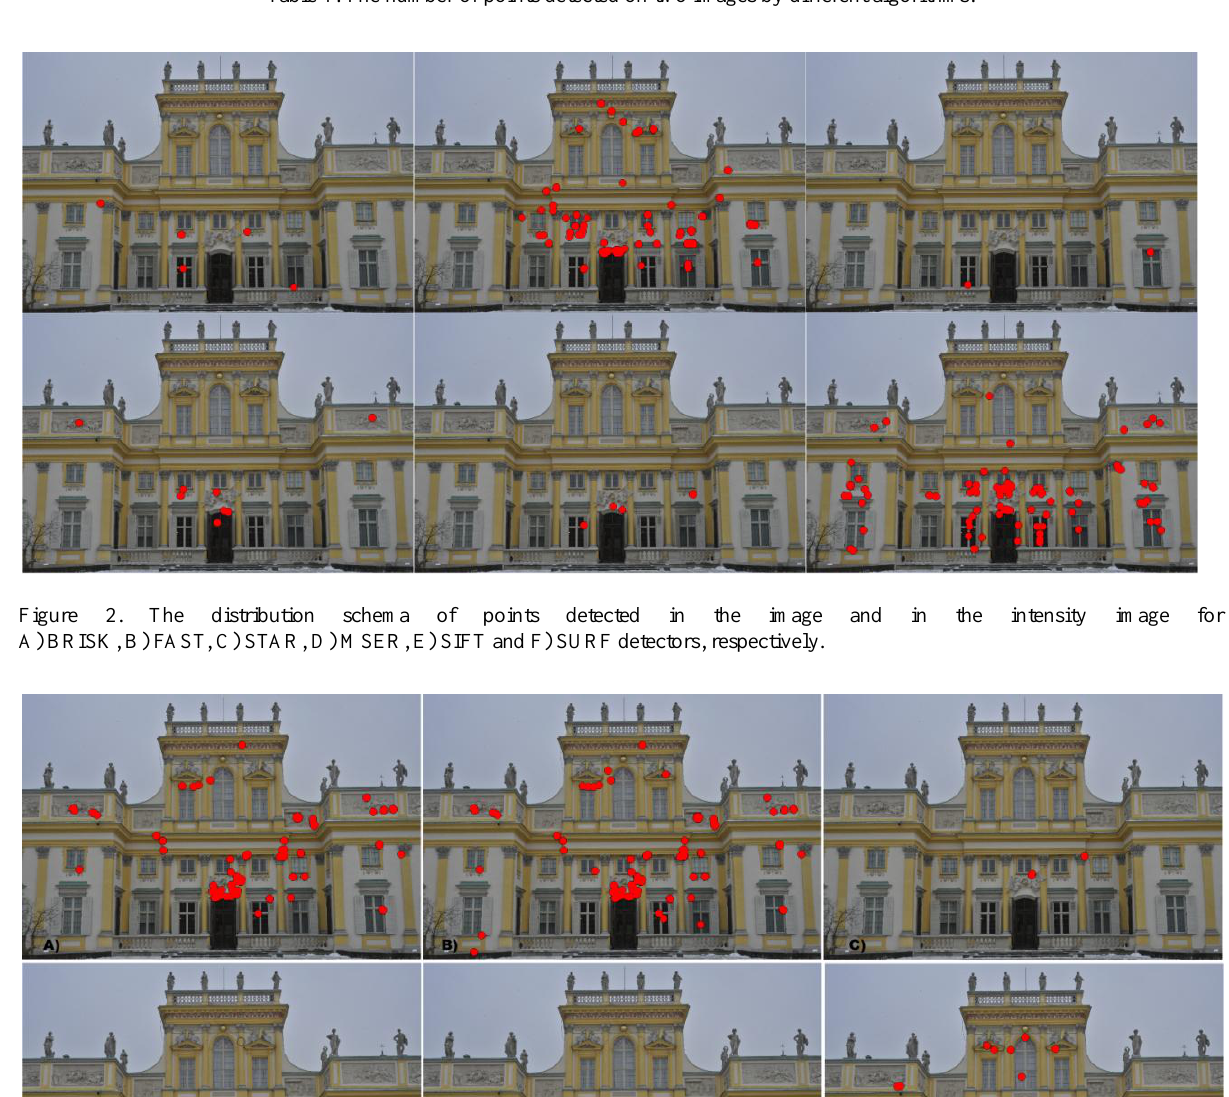
Table 1. The number of points detected on two images by different algorithms.